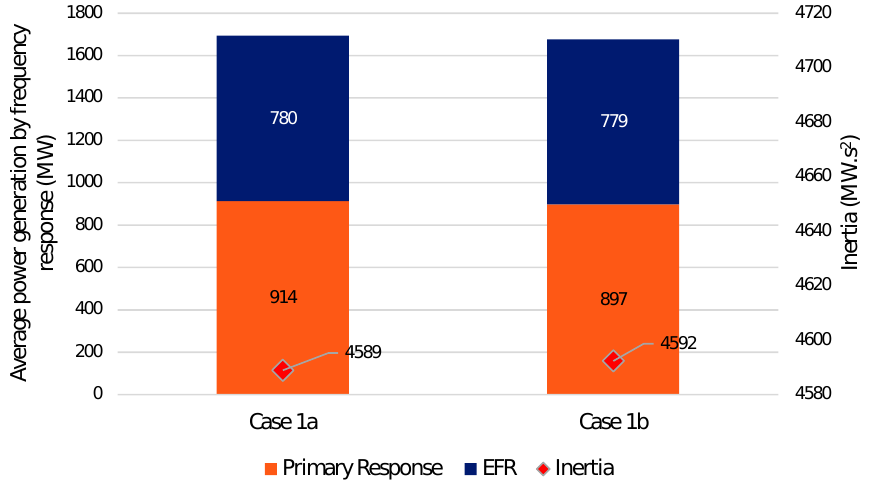
Figure 9. Average hourly frequency response requirement and inertia for Case study 1.